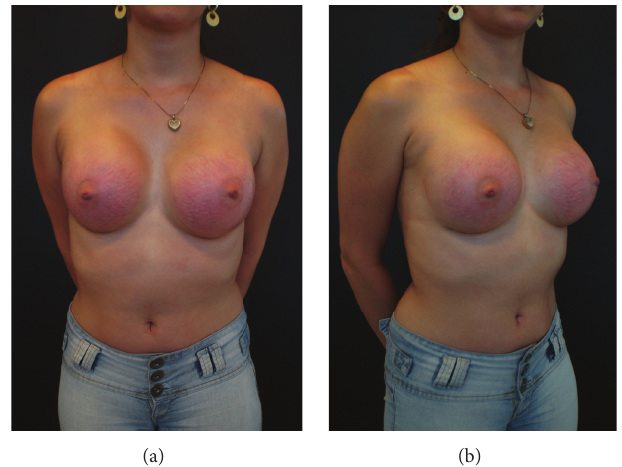
Figure 1: SD 9 weeks after 350 mL breast implants placement in a 29-year-old woman. (a) Frontal view, (b) oblique view.